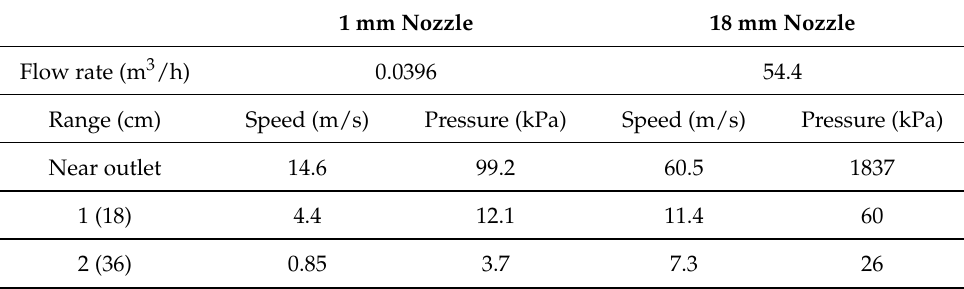
Figure 2. CFD simulation test with two different nozzles. Table 2. CFD simulation results with 1 mm and 18 mm